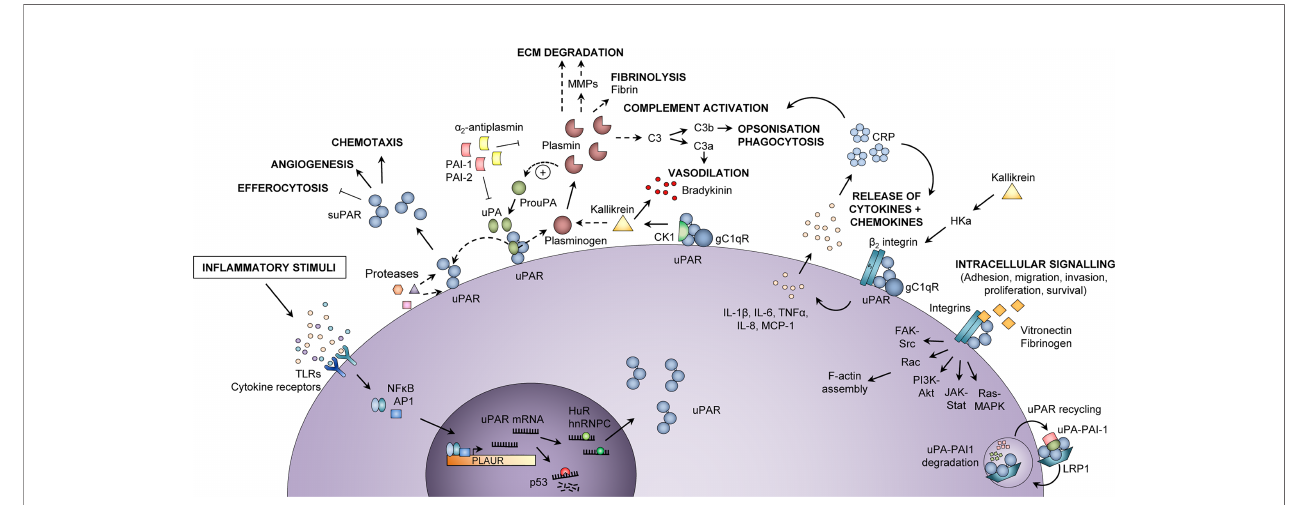
FIGURE 1 | In fl ammatory functions of uPAR and suPAR. Upon an in fl ammatory stimulus, e.g., stimulation of toll-like receptors (TLRs) or cytokine receptors, the expression of urokinase plasminogen activator receptor (uPAR) in immunologically active cells is increased via activation of transcription factors, such as nuclear factor kappa-light-chain-enhancer of activated B cells (NF- k B) and activator protein 1 (AP1), which bind to the promoter region of the PLAUR gene. The uPAR mRNA is either degraded (by p53) or stabilized for translation (by HuR or hnRNPC), after which uPAR is expressed at the cell surface, bound to the membrane via a glycosyl phosphatidylinositol (GPI) anchor. At the cell surface, uPAR can become cleaved by various proteases or its own ligand urokinase plasminogen activator (uPA), thus generating suPAR, which plays a role in in fl ammation by impairing neutrophil efferocytosis and stimulating angiogenesis and chemotaxis. Active uPA cleaves plasminogen to plasmin, which in turn cleaves and activates uPA. Plasmin activates matrix metalloproteases (MMPs), cleaves extracellular matrix (ECM) components, degrades fi brin, and activates the classical complement pathway, thereby promoting migration and invasion of cells, fi brinolysis, vasodilation, opsonization, and phagocytosis of foreign pathogens. Co-localization of uPAR with the proteins cytokeratin-1 (CK1) and globular C1q receptor (gC1qR) on the surface of endothelial cells also promotes vasodilation through release of bradykinin via activation of kallikrein. In a complex with b 2 integrin and gC1qR, uPAR also induces release of cytokines (IL-1 b , IL-6, TNF a ) and chemokines (IL-8, MCP-1), upon stimulation by cleaved high molecular weight kininogen (HKa). Cytokines stimulate the production of C-reactive protein (CRP) from the liver, and CRP itself functions as an opsonin and also activates the classical complement pathway. Furthermore, uPAR interacts with vitronectin, fi brinogen, and integrins, mainly a M b 2 integrin (Mac-1) but also b 1 and b 3 integrin complexes, activating intracellular signaling pathways that facilitate cell adhesion, migration, invasion, proliferation, and survival by affecting F- actin assembly and gene transcription. The activity of uPA and plasmin is inhibited by plasminogen activator inhibitor (PAI)-1, PAI-2, and a 2 -antiplasmin. Binding of PAI-1 and low-density lipoprotein receptor-related protein 1 (LRP1) mediates endocytosis of uPAR-uPA-PAI-1 complexes, followed by lysosomal degradation of uPA and PAI-1 and recycling of uPAR back to the membrane. In endothelial cells, co-localization of uPAR with CK1 and gC1qR activates kallikrein and promotes the release of the vasodilator bradykinin. hnRNPC, heterogeneous nuclear ribonucleoprotein C; HuR, Hu antigen R; IL, interleukin; MCP-1, monocyte chemoattractant protein-1; TNF a , tumor necrosis factor a . Adapted from Rasmussen, LJH (2018) (19) with